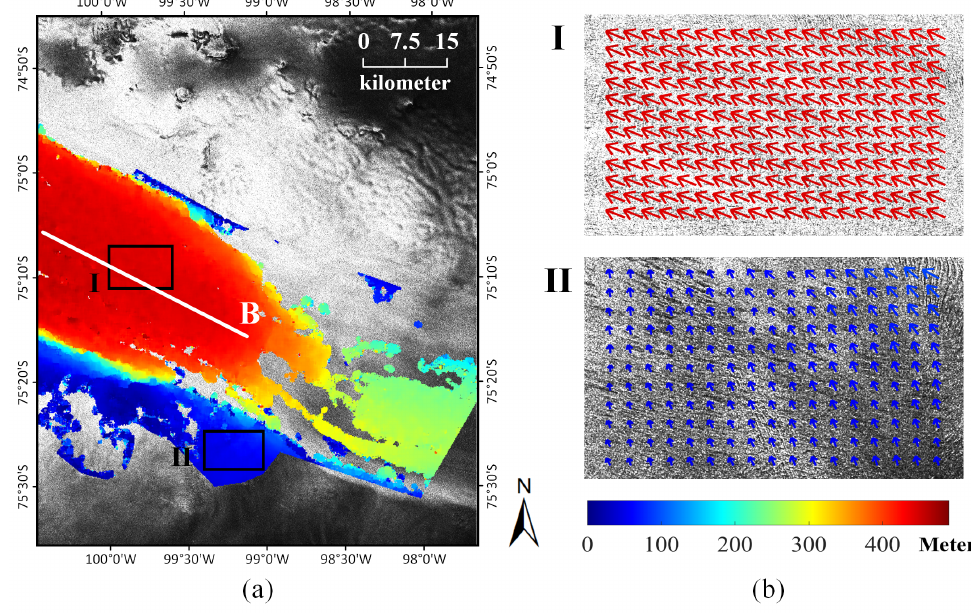
Figure 8. ( a ) Magnitudes of surface motions over the glacierized regions of the Pine Island Glacier; and ( b ) motion field of the glacier surface in the selected